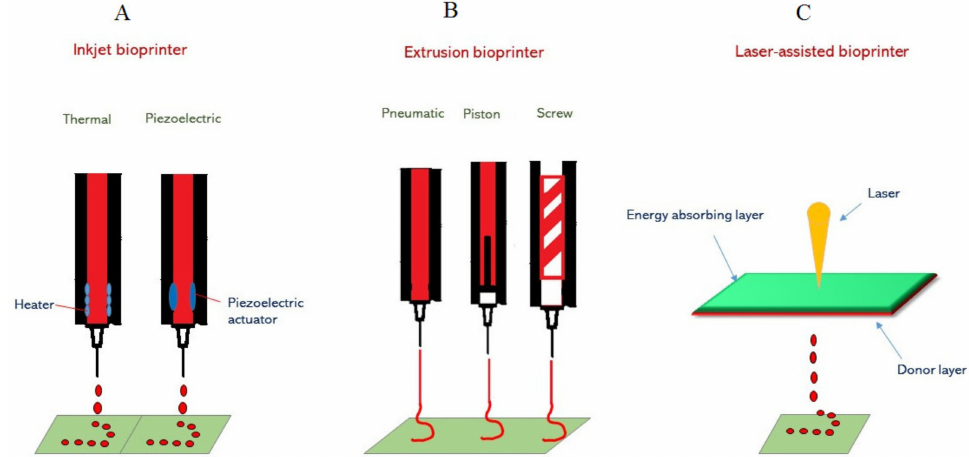
Figure 1. A representation of methods for 3D printing by inkjet, micro-extrusion, and laser-assisted bioprinters. ( A ) Inkjet printing (thermal and piezoelectric). In thermal inkjet printers, a heater creates air-pressure pulses resulting in the generation of droplets on the print. For piezoelectric inkjet printing, a mechanical pulse is generated by an actuator that forces the bio-ink droplets from the nozzle. ( B ) In 3D printing by micro-extrusion, three dispensing systems (pneumatic, piston-driven, and screw-driven robotics) are used to produce a continuous stream of hydrogel containing cells. ( C ) In laser-assisted bioprinting, laser energy induces bubble nucleation and forces droplets of bio-ink towards the